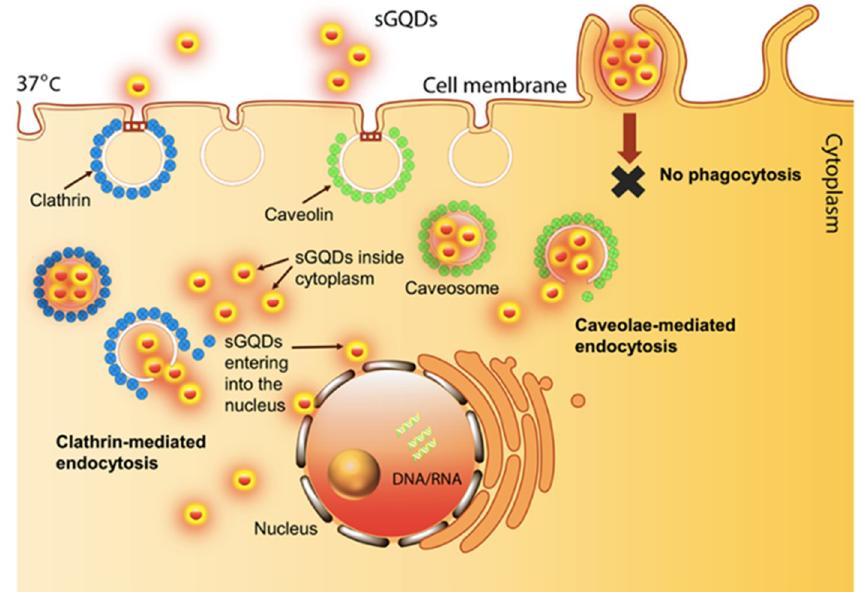
Figure 9. Nucleus labeling was performed when sGQDs were directed towards the cell nucleus by themselves. The figure represents the cellular and nuclear uptake of the sGQDs by endocytosis mediated by clathrin and caveolin endocytosis inside the cell. The uptake mechanism shows the localization of sGQDs inside the nucleus. Even though the sGQDs could not bear any nuclear localizing agent, according to the previous studies, their small size, surface charge, histone-chaperones, and nuclear-localization signals execute localizing inside the nucleus. Thus, the nucleus imaging and potential drug delivery applications with sGQDs are more likely to happen with their eco-friendly features. In addition, with no ROS generation, this nucleus staining method is confirmed to be biocompatible and non-cytotoxic